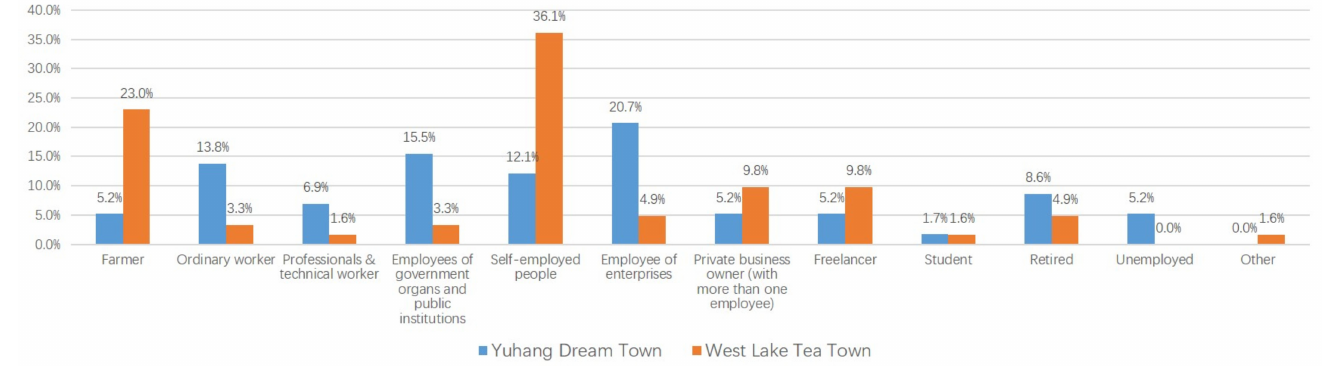
Figure 6. Employment distribution of respondents (source: authors).